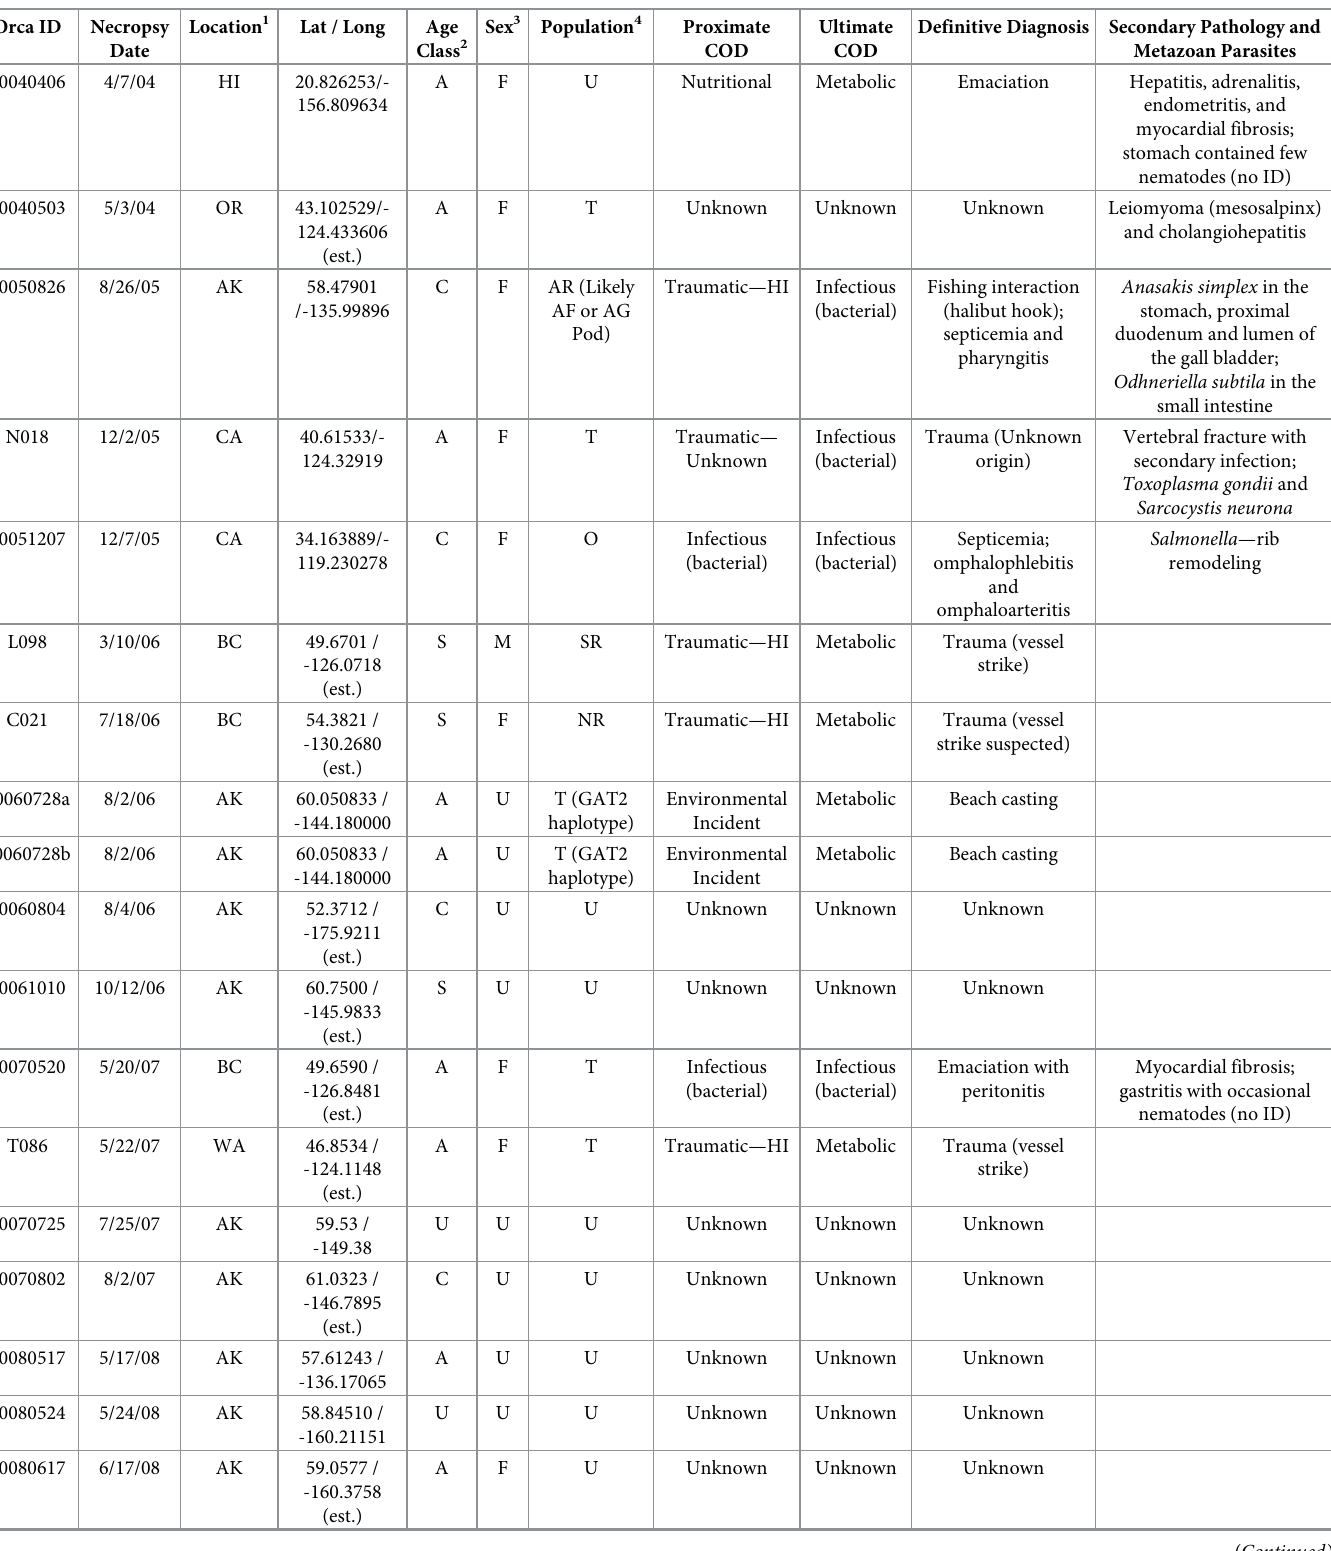
Table 1. Cause of death for killer whales examined from